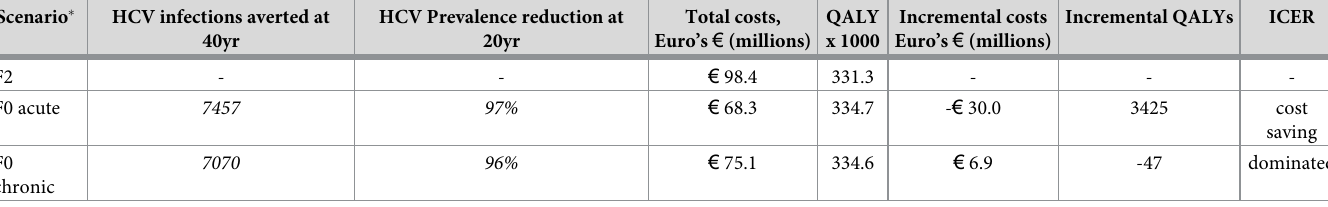
The reported numbers are median values with the corresponding interquartile ranges between brackets. Abbreviations: HCV: hepatitis C, QALYs: Quality Adjusted Life Years, ICER: incremental cost-effectiveness ratio.